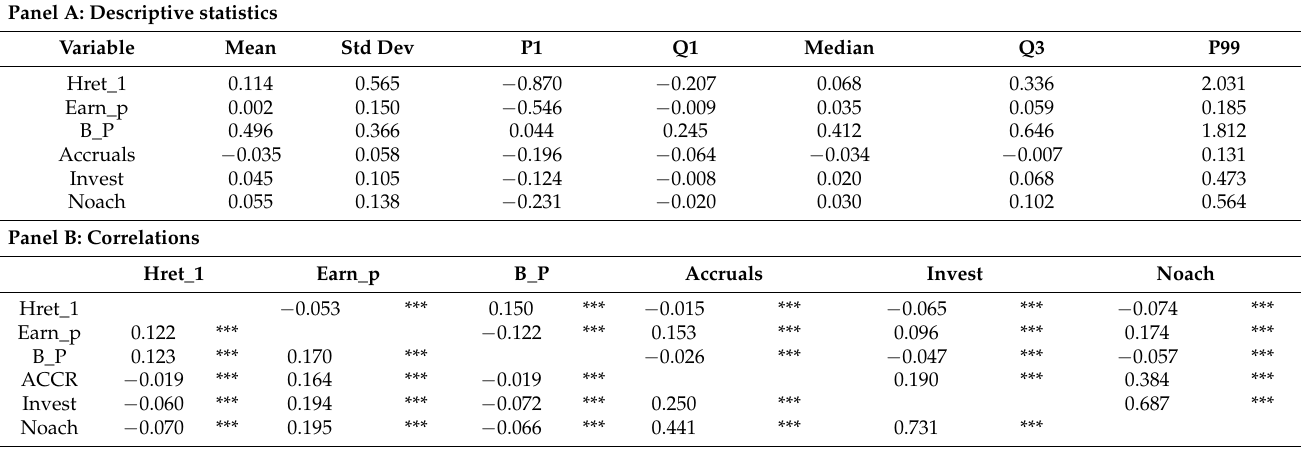
Table 8. Penman and Yehuda (2016) Model for Expected